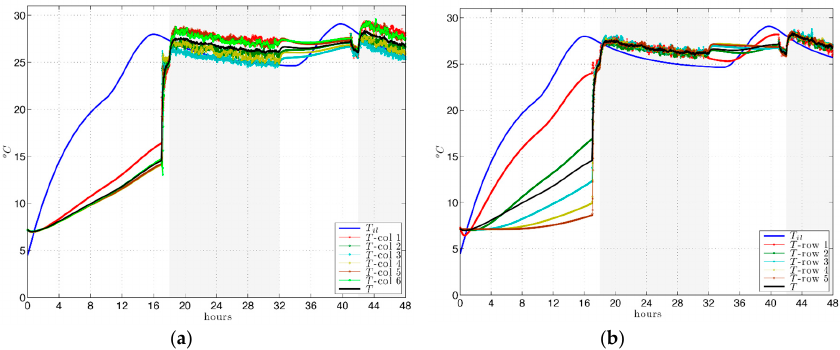
Figure 6. Case 1: Le Corbusier hypothesis. Winter. Internal layer temperature T il and averaged room temperature T together with calculated indoor temperatures at the probe points given in Figure 3. ( a ) by columns; ( b ) by rows.